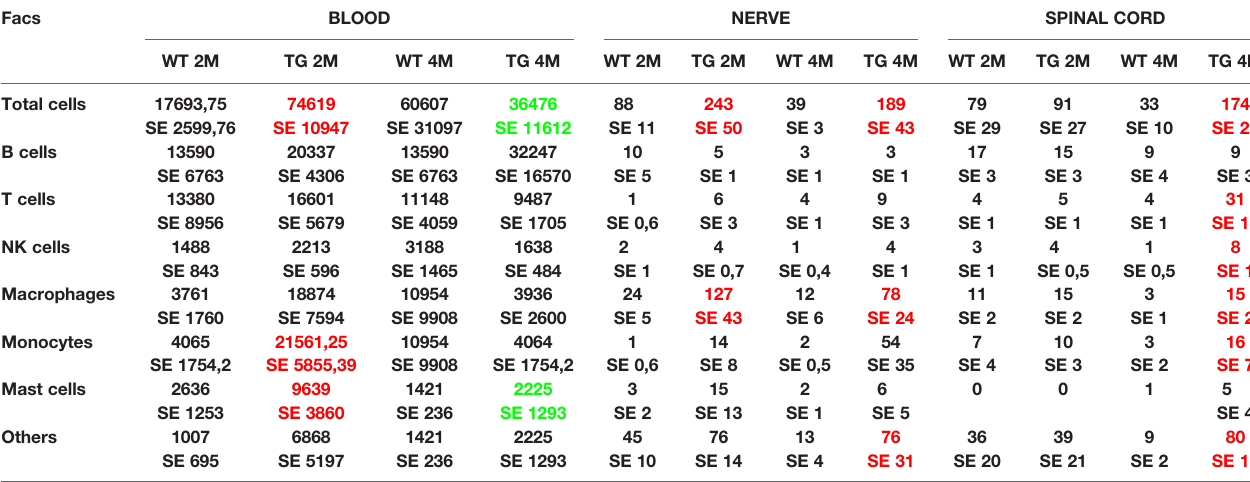
The table resumes the mean value (SE = standard error) of different immune cells. Red values indicate the signi fi cant differences between genotypes (TG = transgenic mice - SOD1-G93A mice vs WT = wild type mice) while green value are the signi fi cant differences regarding the age (2M vs